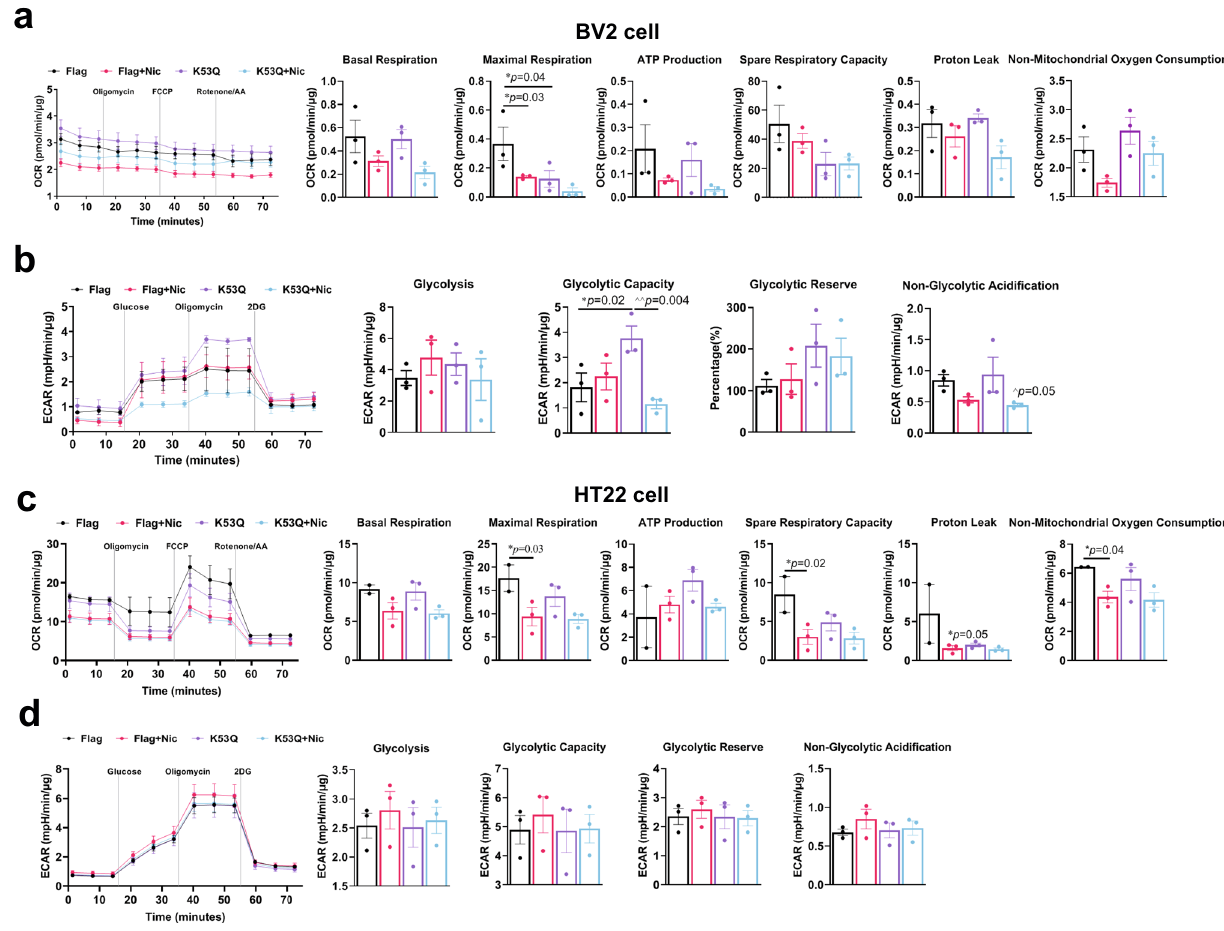
Fig. 7 | Nicotine improved the OCR and ECAR in NAMPT-K53Q mutation cells. The effects of nicotine on OCR measurement a and ECAR measurement b in BV2 cells ( n =3, biologically independent samples/group). The effects of nicotine on OCR measurement c and ECAR measurement d in HT22 cells ( n =2 – 3, biologically independent samples/group). The quantitative analysis of OCR including, basal